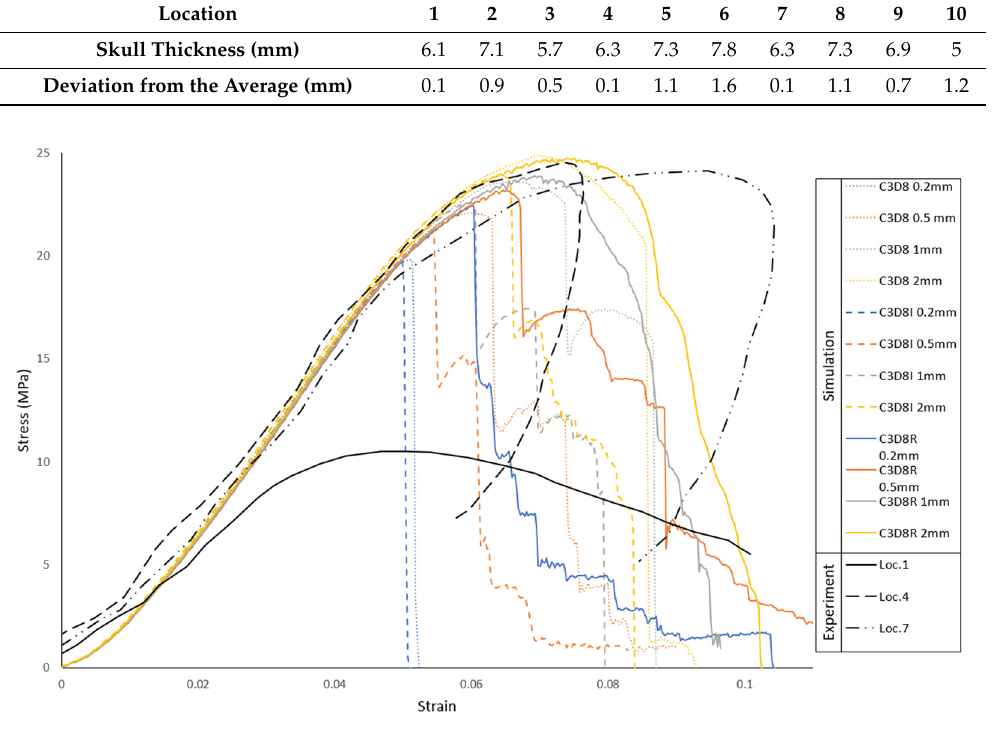
Figure 10. Damage model influence, with and without unloading in comparison with the experiments from all the locations.